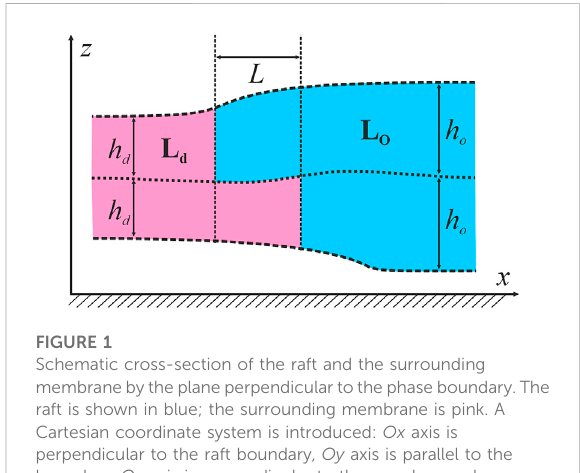
FIGURE 1 Schematic cross-section of the raft and the surrounding membraneby theplane perpendiculartothephase boundary.The raft is shown in blue; the surrounding membrane is pink. A Cartesian coordinate system is introduced: Ox axis is perpendicular to the raft boundary, Oy axis is parallel to the boundary, Oz axis is perpendicular to the membrane